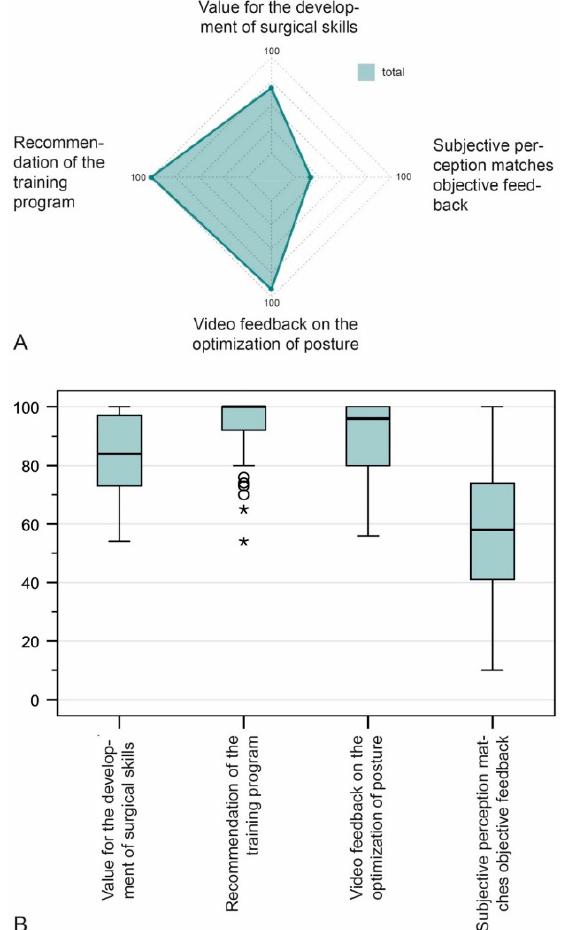
Figure 5. Evaluation of the course by all participants on the radar plot, with regard to four questions plotted on the x-axis. For better illustration, only the medians 50 to 100 are shown ( A ). The box plots show the evaluation of all participants. Circles and stars represent outliers; the black horizontal line within the box plot is the median ( B ).